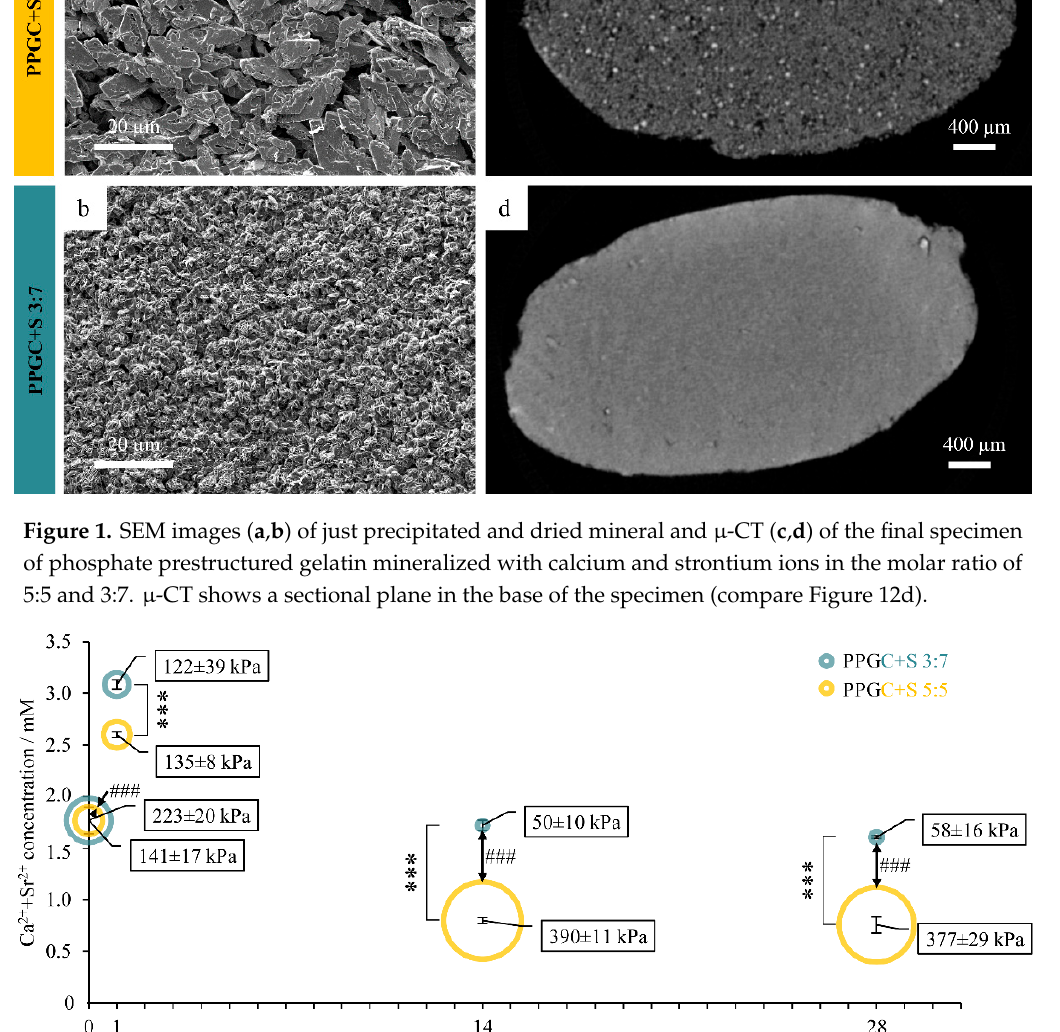
Figure 1. SEM images ( a , b ) of just precipitated and dried mineral and µ-CT ( c , d ) of the final specimen of phosphate prestructured gelatin mineralized with calcium and strontium ions in the molar ratio of